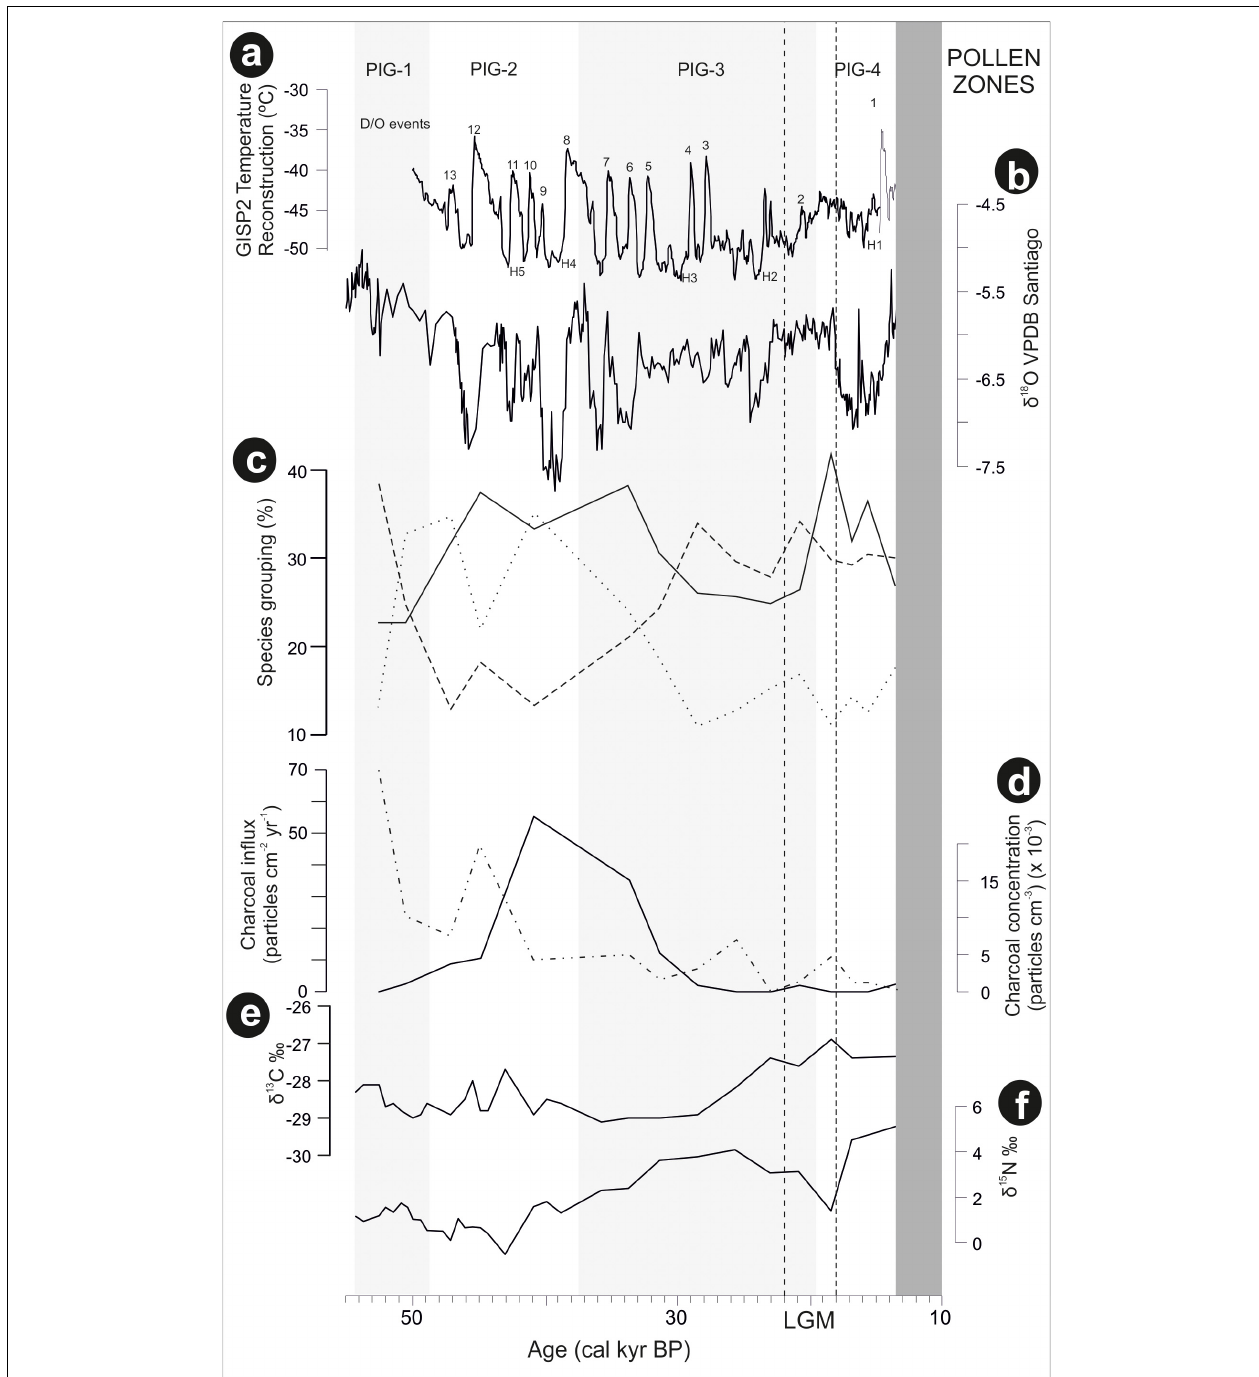
FIGURE 5 | Laguna Pindo metrics and additional data framed in a regional palaeoclimatic context (raw data downloaded from NOAA): (a) GISP2 temperature reconstruction of Greenland (Alley, 2000), in which are shown the Heinrich (H) and Dansgaard–Oeschger (D/O) events that occurred in the time interval under study; (b) precipitation reconstruction based on Santiago speleothem record (Mosblech et al., 2012); (c) percentages of the groups resulted in the cluster analysis of Laguna Pindo most abundant palynological taxa ( Figure 4 ): with dotted, dashed, and continuous lines showing the different groups (Group 1, 2, and 3 of Figure 4 , respectively); (d) local fires curve of Laguna Pindo based on big ( > 100 µ m) charcoal particles, expressed in concentration and influx values (continuous and discontinuous lines, respectively); (e) δ 13 C of Laguna Pindo, expressed in ; and (f) δ 15 N of Laguna Pindo, expressed in . The dark grey shade represents the hiatus of Laguna Pindo, calculated as the calibrated ages of the dated samples bracketing the sedimentary gap (at 512 and 514 cm depth), and the light grey bands (cid:104) (cid:104) mark the pollen zones obtained. Vertical dashed lines show the LGM core interval following Figure 3 .